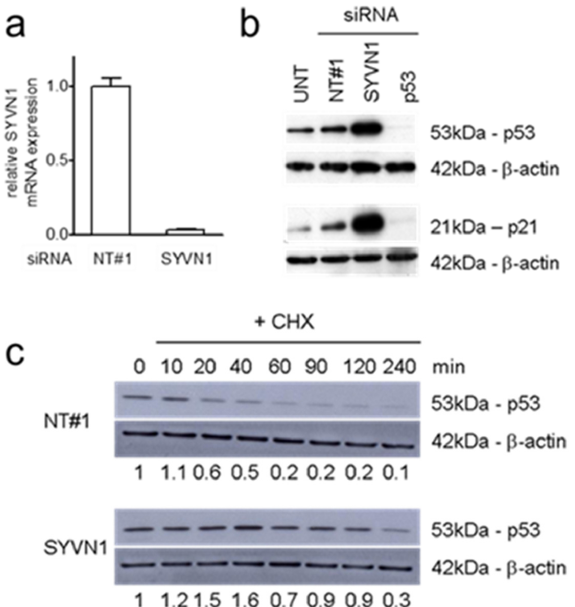
Figure 2. Silencing SYVN1 in A549 cells inhibits p53 degradation. ( a ) Quantification of SYVN1 mRNA in A549 cells transfected with negative control siRNA NT#1 or SYVN1 siRNA as indicated. The SYVN1 mRNA level was assessed by RT-qPCR and normalized to GAPDH mRNA. ( b ) SYVN1 silencing in A549 cells increases p53 protein levels (upper panels) and causes functional activation of p53, as evidenced by enhanced p21 expression (lower panels), determined by Western Blot analysis 96 h after siRNA transfection. siRNA against TP53 is included as control, eliciting an opposite effect. UNT, untransfected control cells. ( c ) SYVN1 silencing increases p53 half-life. Western blot analysis for p53 and β -actin was done at the indicated time points after siRNA transfection in the presence of cycloheximide (CHX). The relative fraction remaining p53 compared to t = 0 as quantified by densitometry and normalized to β -actin is given below the panels.